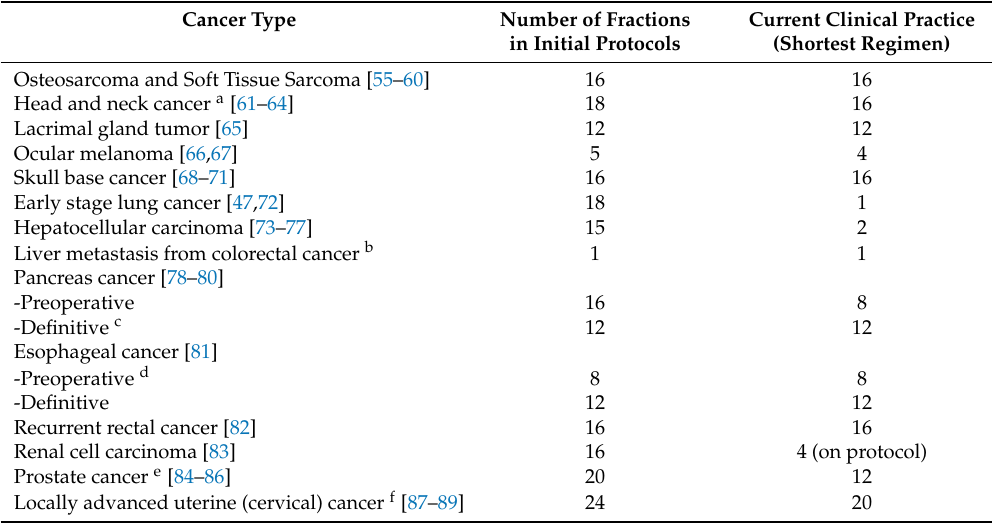
Table 3. Summary of initial and current fractionation schedules for the most common cancers treated at the National Institute of Radiological